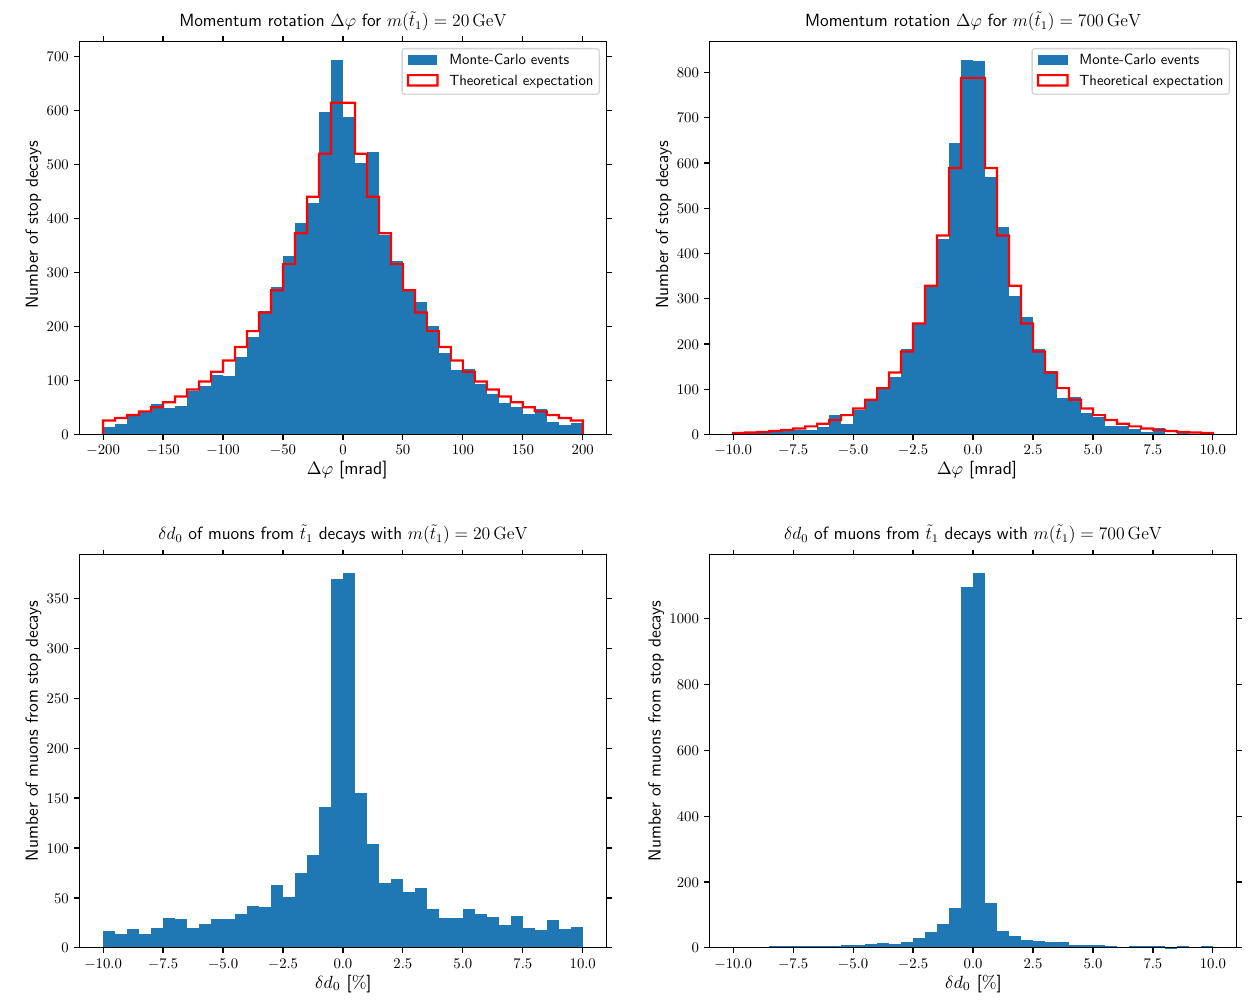
Fig. 1 Distribution in the angle Δϕ (top row) associated with the rota- tion to which the momentum of the R -hadrons originating from the process (2.2) is subjected, when they propagate in a magnetic field of 4 T. The associated deviation δ d 0 on the transverse impact parameter of